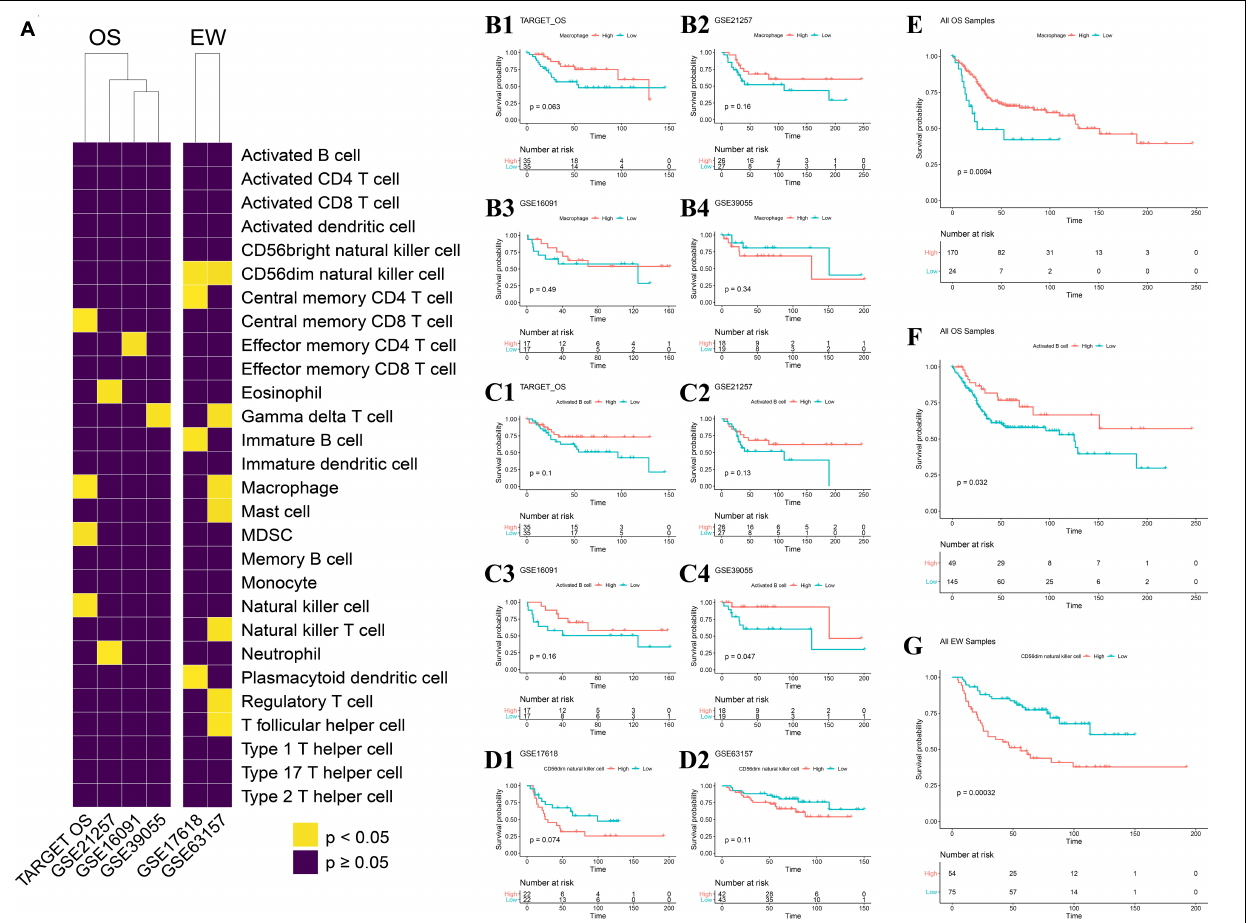
FIGURE 5 | Impact of each immune infiltration score on patients with the four diseases. (A) Univariate COX analysis across four OS datasets and two EW datasets; result shown in heatmap, yellow represents p < 0.05, violet represents p ≥ 0.05. (B1–B4) Association of macrophage ES score to OS-specific overall survival in each of the four datasets. (C1–C4) Association of activated B cell ES score to OS-specific overall survival in each of the four datasets. (D1,D2) Association of CD56dim natural killer cell ES score to EW-specific overall survival in each of the two datasets; median ES score of each cell type per dataset was applied as the cutoff value. (E) Association of macrophage ES score to OS-specific overall survival across all samples of the four OS datasets. (F) Association of activated B cell ES score to OS-specific overall survival across all samples of the four OS datasets. (G) Association of CD56dim natural killer cell ES score to EW-specific overall survival across all samples of the two EW datasets; median ES score of each cell type across all samples in 22 datasets was applied as the cutoff value. OS, osteosarcoma; EW, Ewing’s